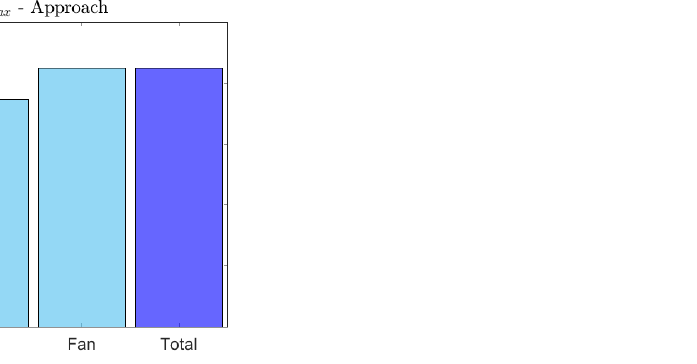
Figure 12. Noise contributions and overall noise for approach measurement